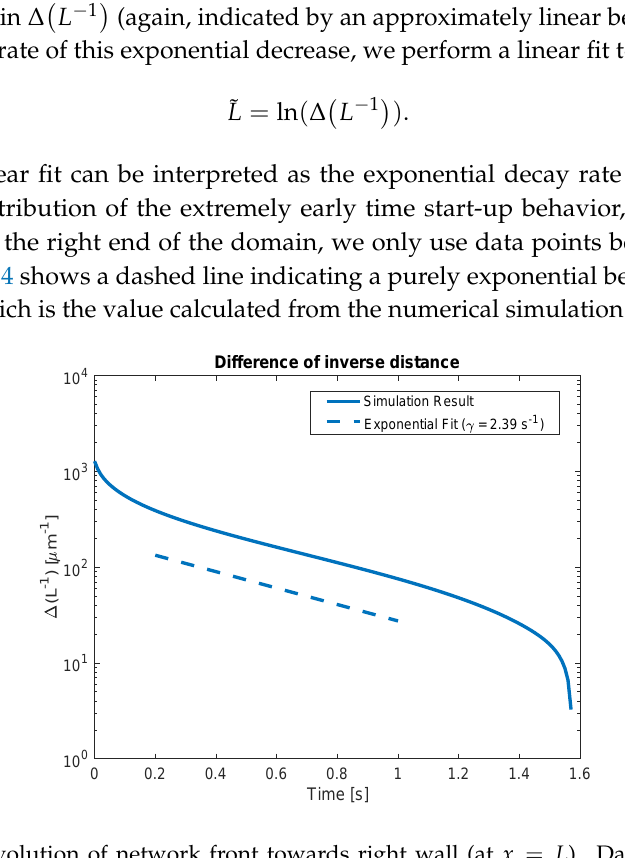
Figure 4. Time evolution of network front towards right wall (at x = L ). Dashed line indicates exponential fit from t = 0.2 to t = 1 s. The slope of this line ( γ = 2.39 s − 1 ) represents the early-time expansion rate of the